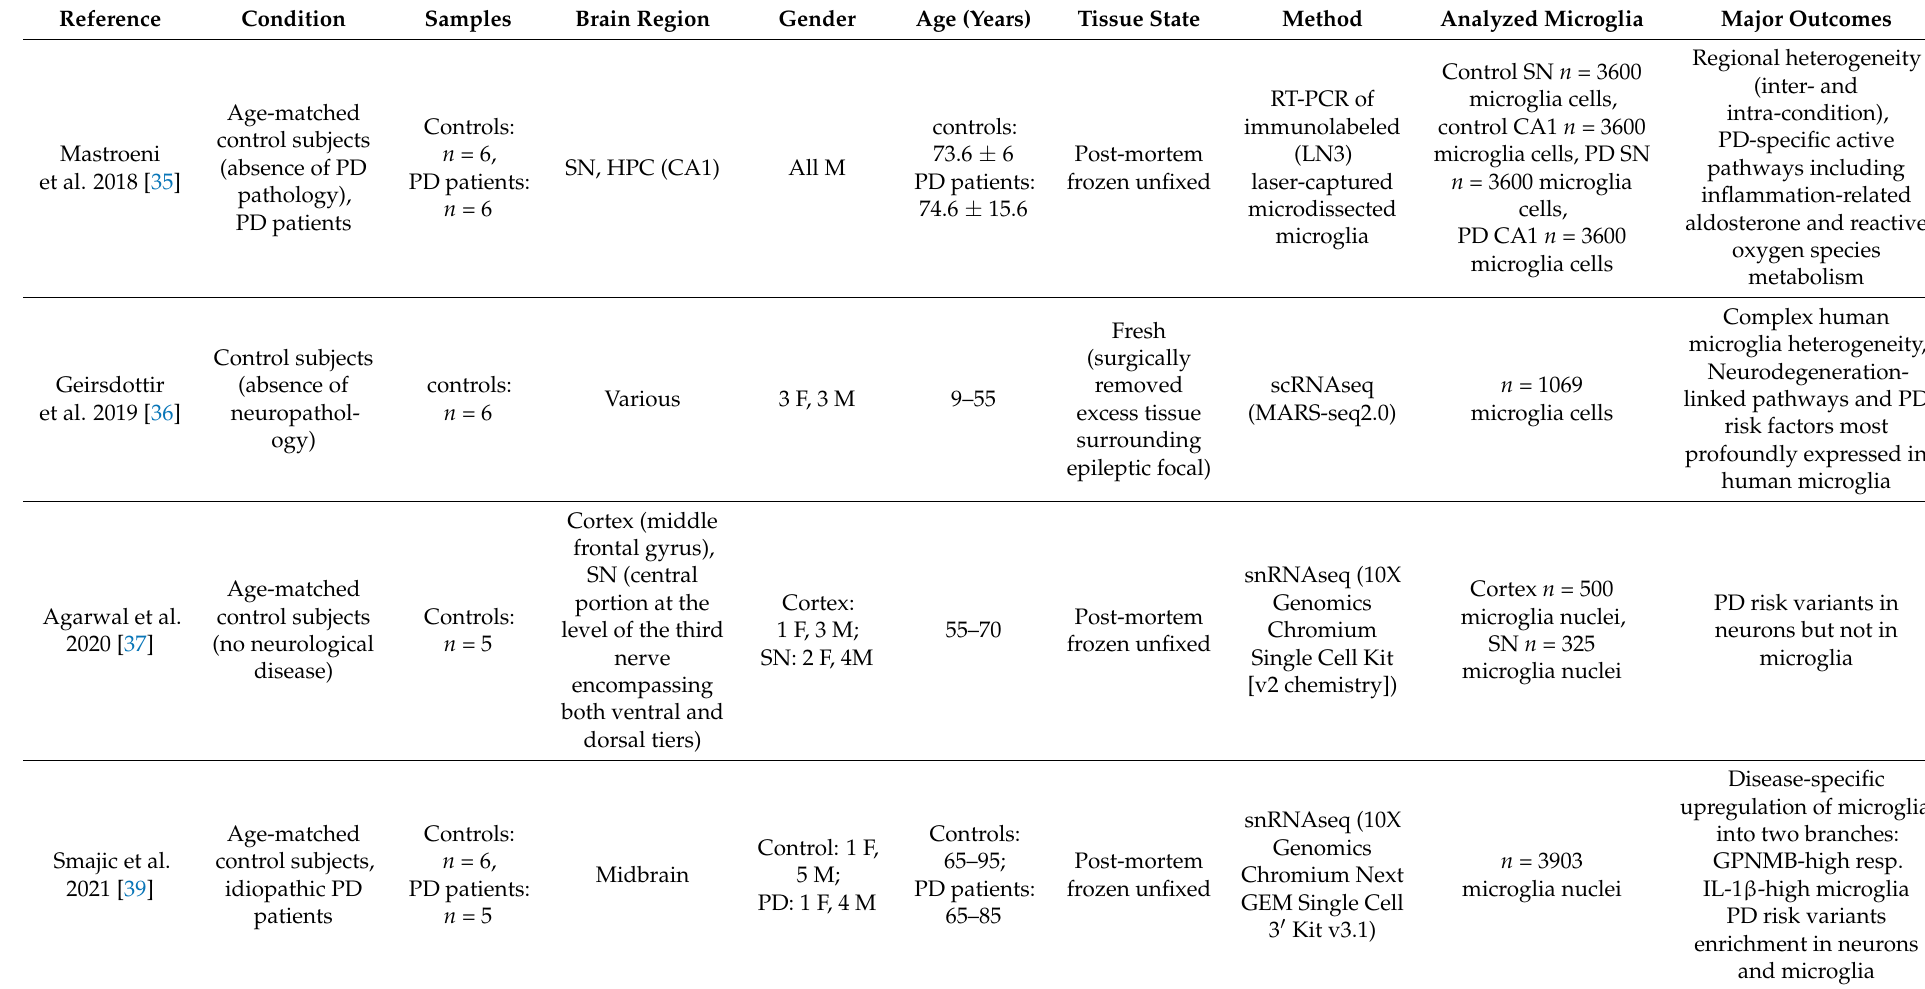
Table 1. Overview of human single cell and single nuclei